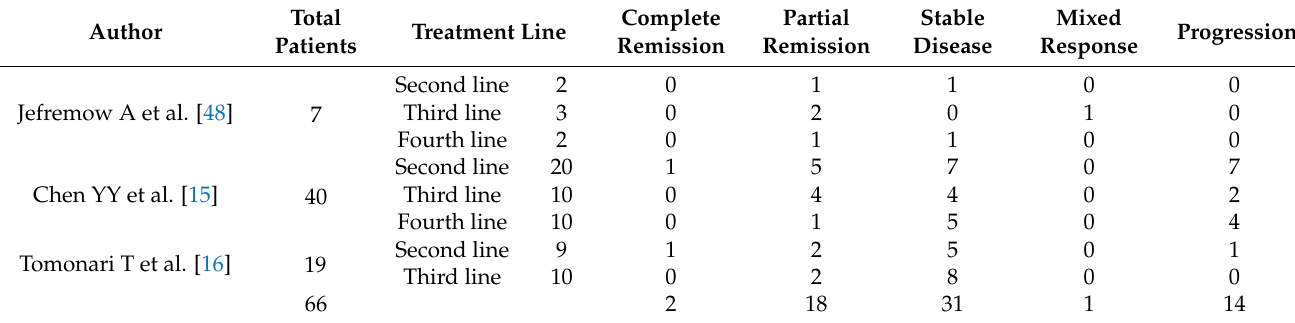
Table 2. Lenvatinib as second-line or further-line treatment after